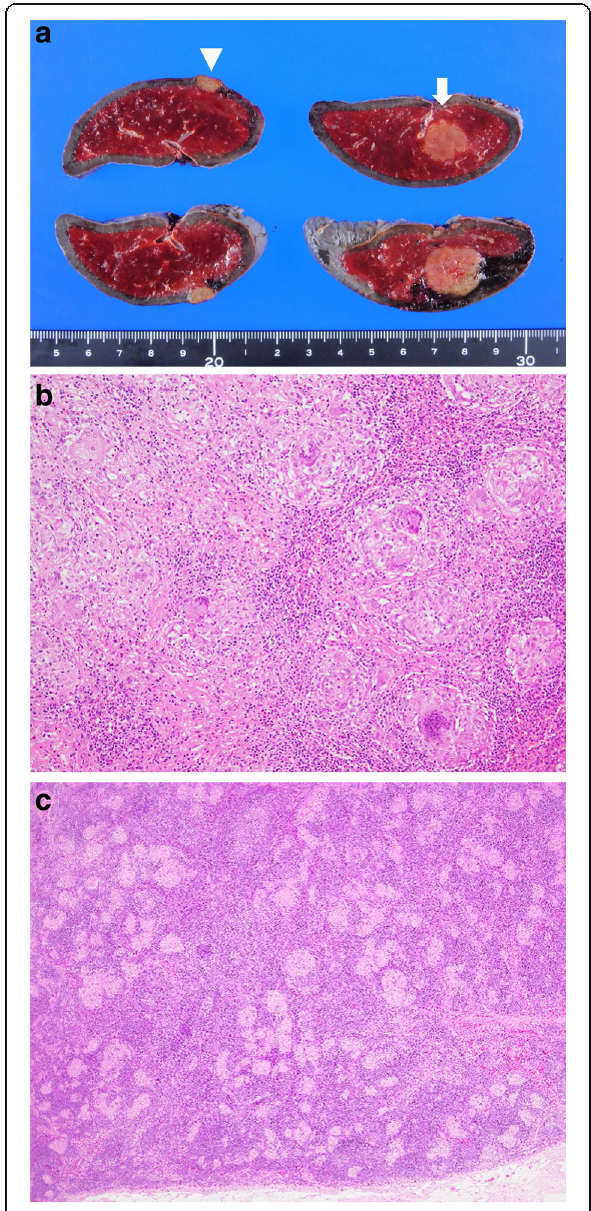
Fig. 6 a Operative specimen showing two splenic tumors measuring 20 mm (arrow) and 7 mm (arrowhead). b Histopathological findings of the spleen showing epithelioid cell granulomas without caseous necrosis and no evidence of malignant cells. c The retrospective histopathological findings of the regional lymph nodes show noncaseous epithelioid granulomas (sarcoid